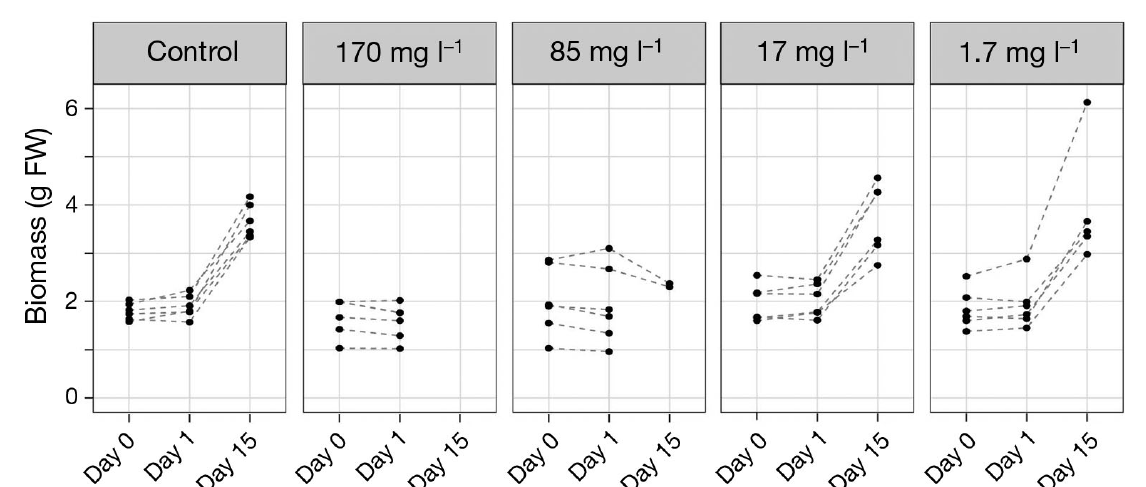
Fig. 7. Effect of 1 h exposure to 5 different concentrations of H 2 O 2 , including control, on biomass of individual juvenile Saccha- rina latissima plants over time at intervals immediately post-exposure (Day 0), 24 h post-exposure (Day 1), and 15 d post- exposure. FW: fresh weight